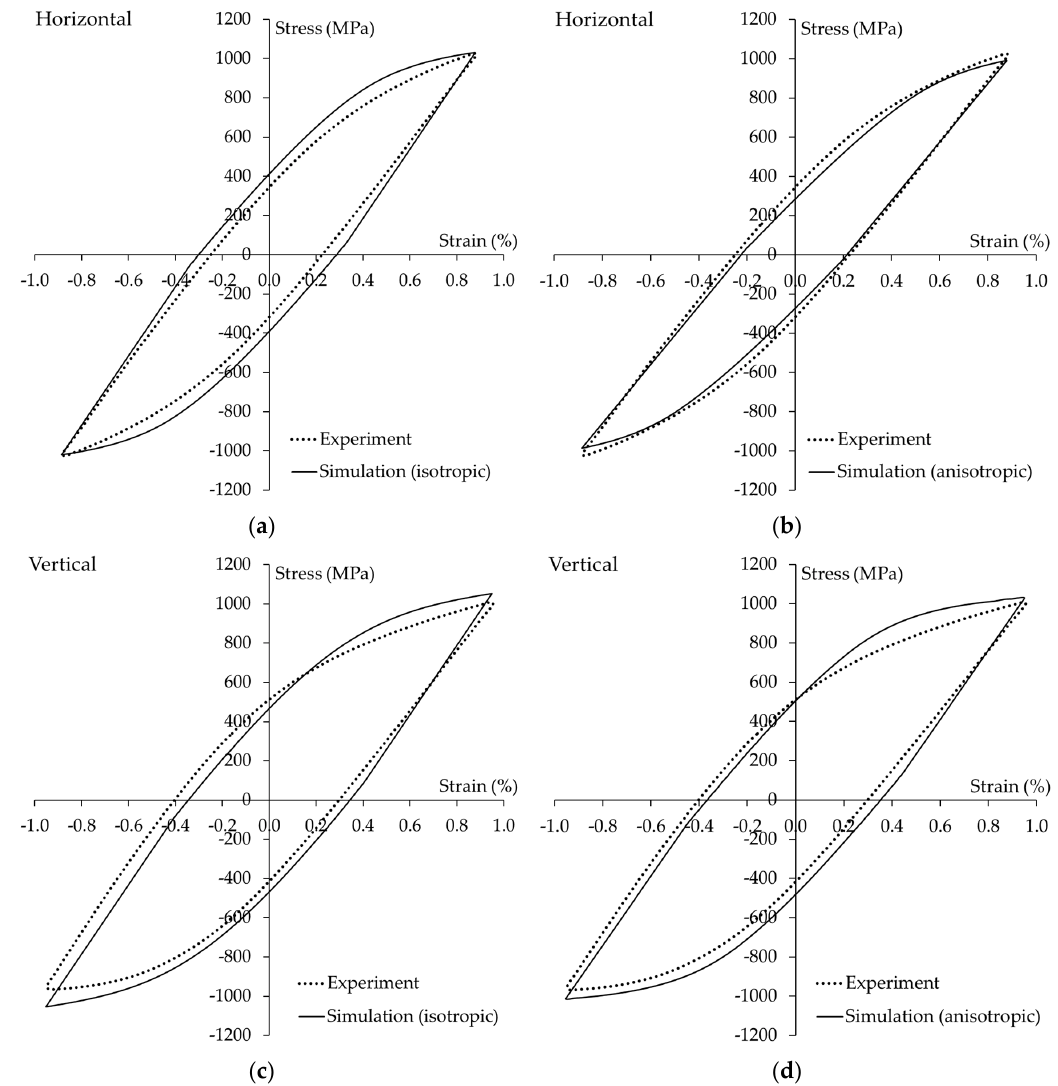
Figure 3. Experimental versus simulation results for the ( a ) isotropic plasticity model for the horizontal coupon; ( b ) anisotropic plasticity model for the horizontal coupon; ( c ) isotropic plasticity model for the vertical coupon; and ( d ) anisotropic plasticity model for the vertical coupon. Table 4. Average error (%) for the vertical and horizontal test coupon experimental and simulation data for the isotropic and the anisotropic plasticity model.